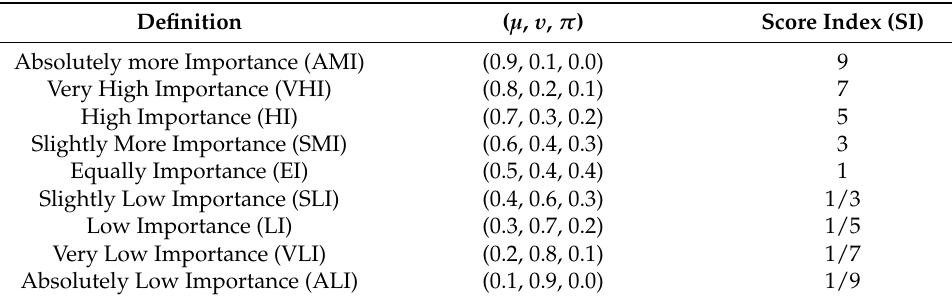
Table 1. SF-AHP linguistic